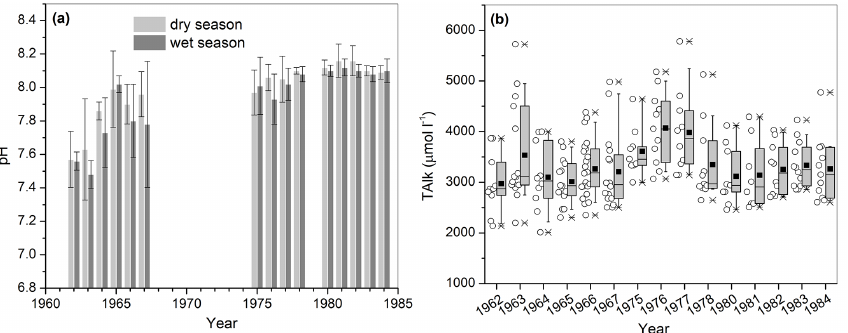
Figure 3. Seasonal comparison of pH (a) and box-and-whisker plot of TAlk (b) at Luokou station. The horizontal line is the median value, the black square is the mean value, the boxes represent the 25th to 75th percentile, the whiskers represent the 10th and 90th percentile, and the asterisks represent the maximum and minimum. Raw TAlk data are added to the left in (b)